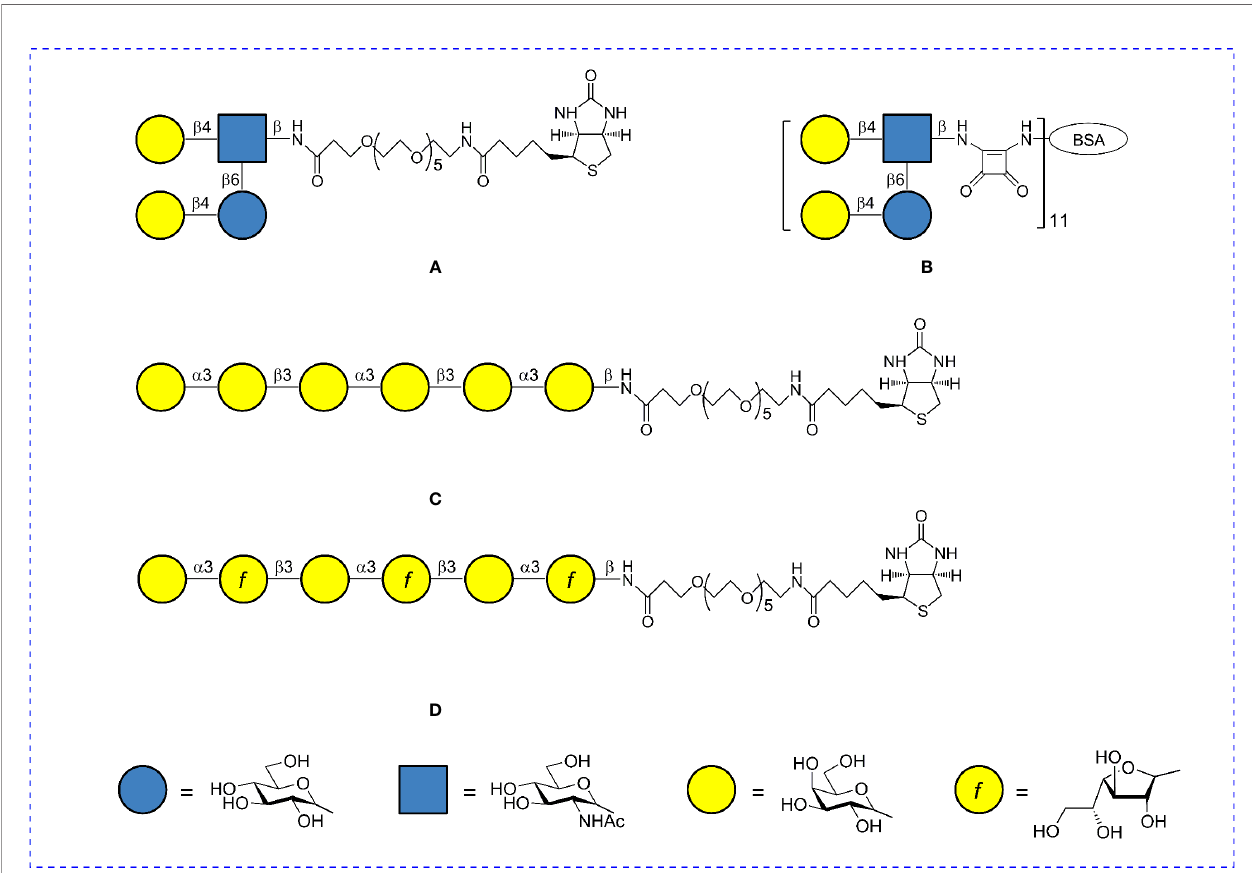
FIGURE 2 | Structures of oligosaccharide conjugates used as negative controls. (A) Biotin conjugate of the tetrasaccharide of S. pneumoniae type 14 CP. (B) BSA conjugate of the tetrasaccharide of S. pneumoniae type 14 CP. (C) Biotin conjugate of the hexasaccharide of K. pneumoniae galactan II. (D) Biotin conjugate of the hexasaccharide of K. pneumoniae galactan